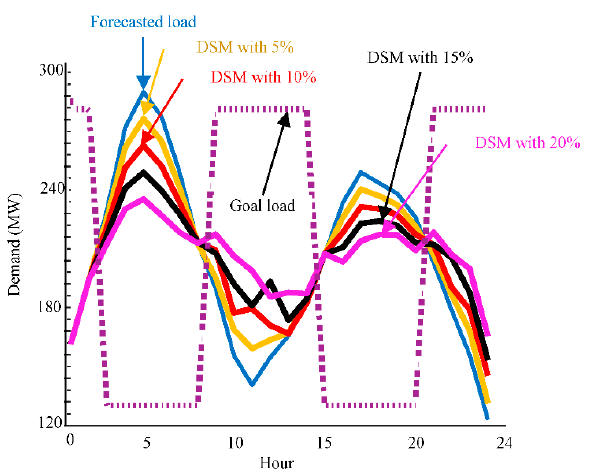
Figure 5. The curves of demand after DSM evaluation by various participation levels.